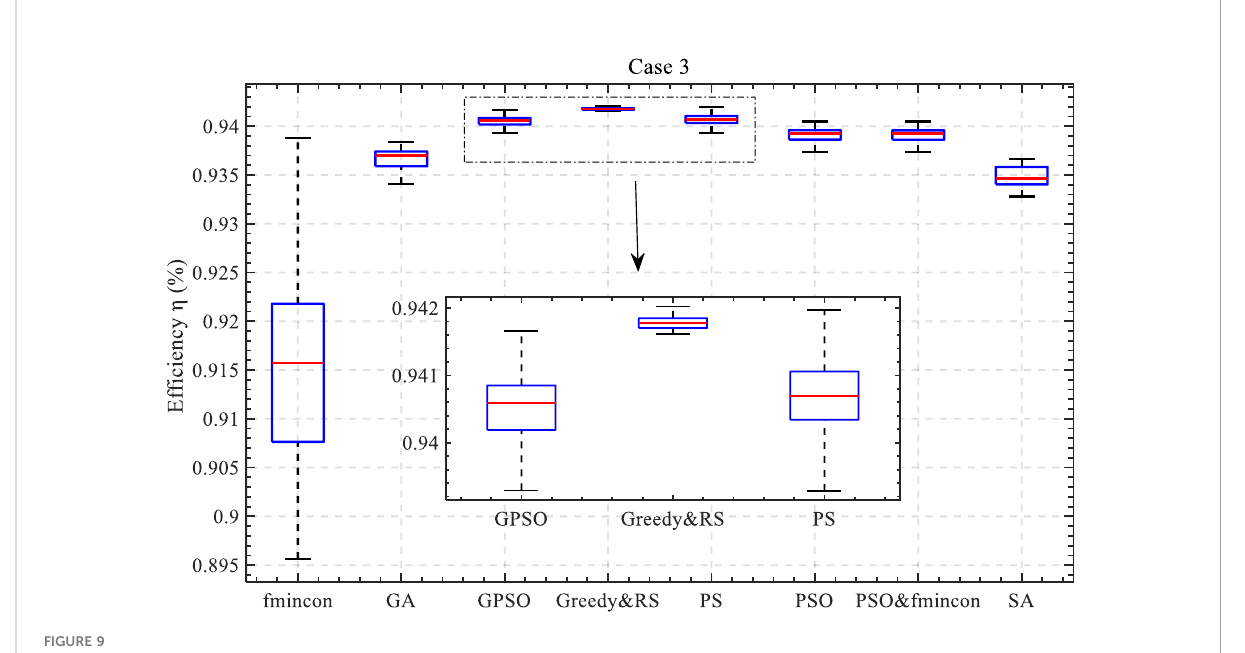
FIGURE 9 Boxplot of wind farm ef fi ciency using different optimization